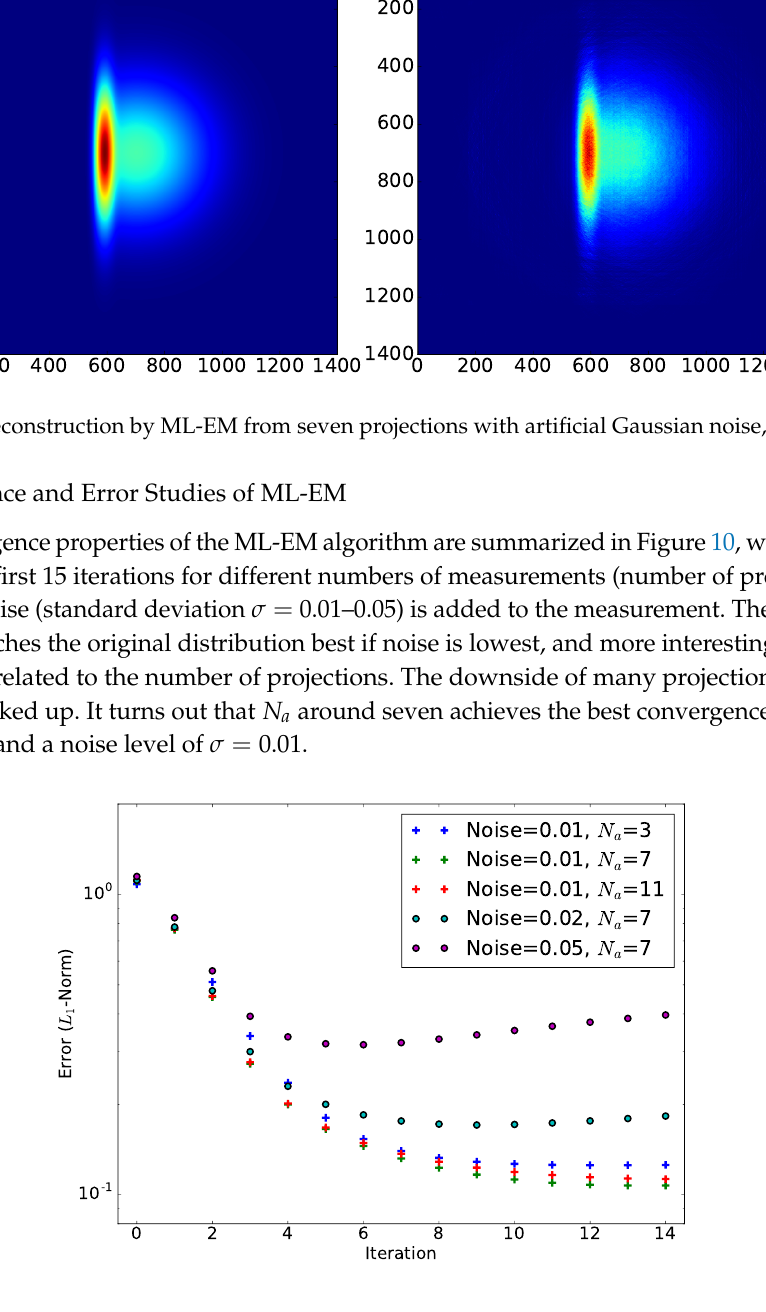
Figure 10. Convergence studies of ML-EM for various degrees of Gaussian noise σ and the number of projection angles N a . Convergence is observed after 7–10